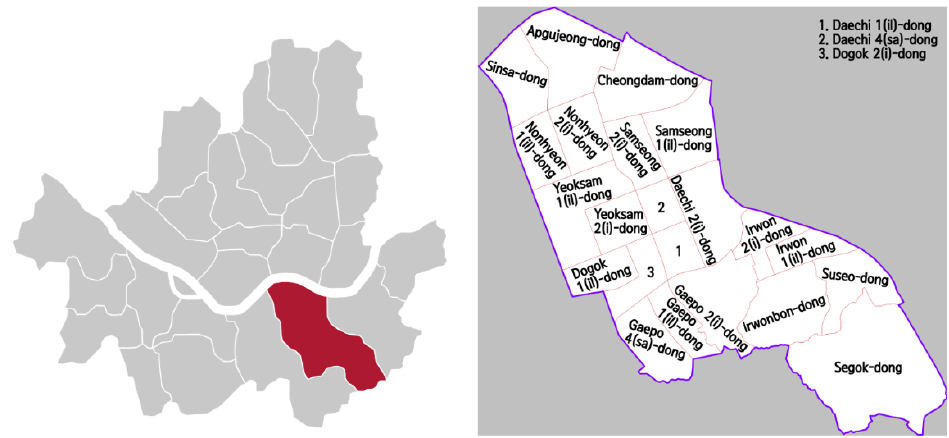
Figure 1. Location of Gangnam and its administrative divisions